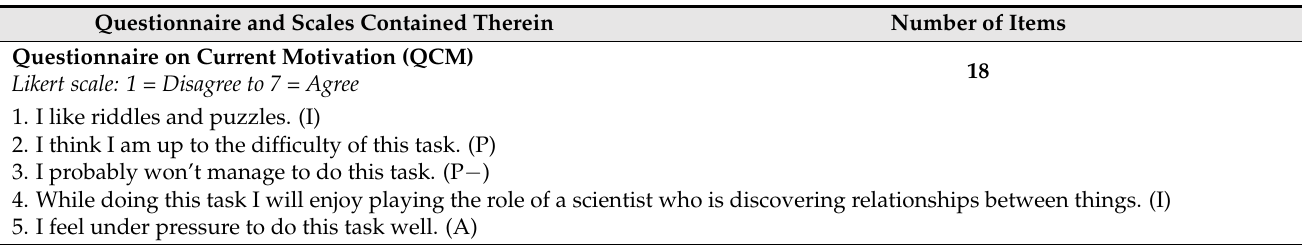
Table A1. Overview of the questionnaires used in the paper-based